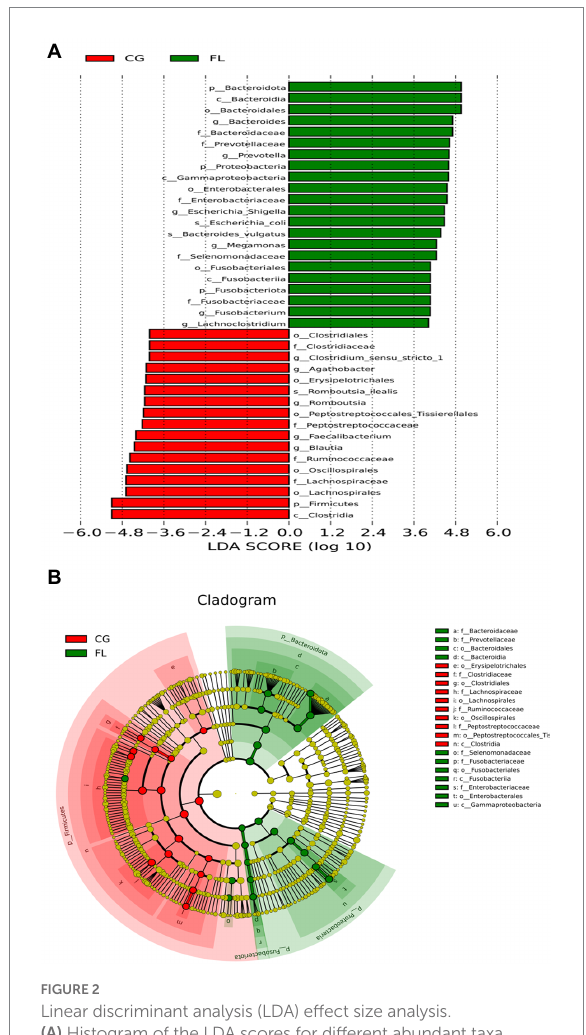
FIGURE 2 Linear discriminant analysis (LDA) effect size analysis. (A) Histogram of the LDA scores for different abundant taxa. Green, enriched in MAFLD patients; red, enriched in CG. (B) Cladogram of LEfSe linear discriminant analysis. Red and green circles represent the differences of the most abundant microbiome class. The diameter of each circle is proportional to the relative abundance of the